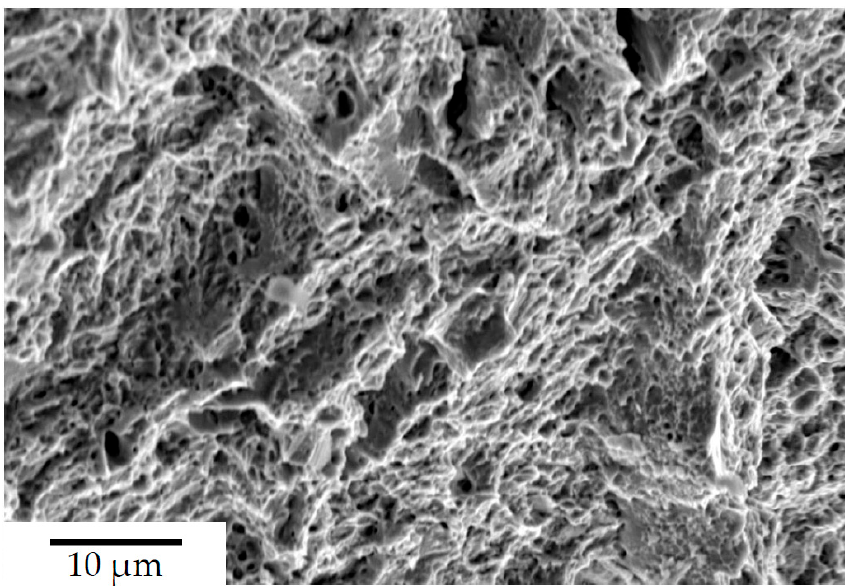
Figure 8. Fracture surface of impact specimen made from steel A0, after heat treatment ③ .